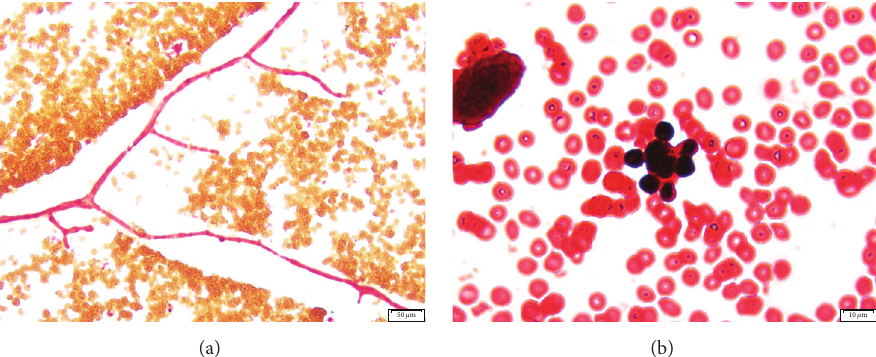
Figure 1: Gram stain of M. circinelloides dimorphic phases from a positive blood culture. (a) Pauciseptate wide hyphae with right-angle branching (100x magnification). (b) Circumferentially budding yeast resembling the yeast phase of Paracoccidioides brasiliensis (500x magnification).